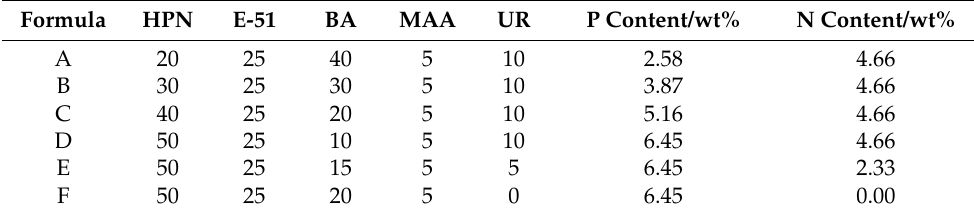
Table 1. Recipe of HPA-EPPA-UR-PA